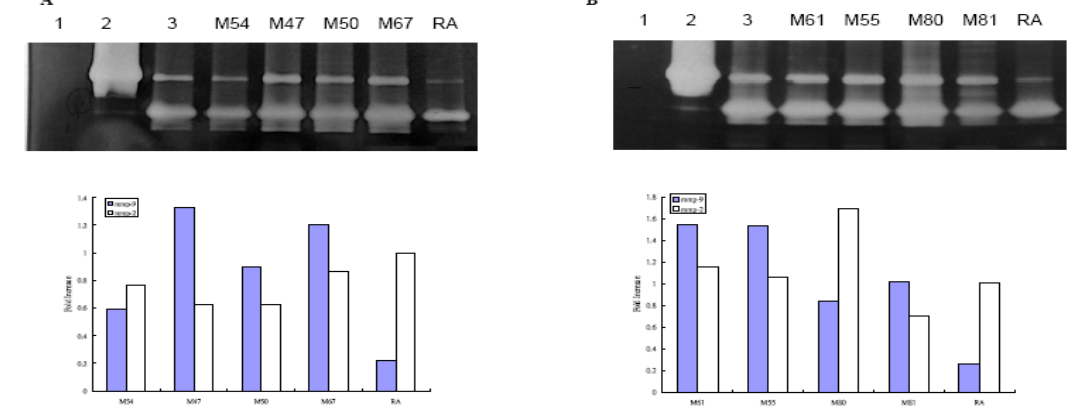
A and B represent MMP-2 and -9 activities of indicated Taiwanese native plants. Lanes 1-3 are negative controls, rMMP-9, medium alone without treatment, respectively. The lower panel represents the semiquantitation the MMP-2 and –9 activities by densitometer (gray and white bars represent MMP-9 and MMP-2 activities, respectively). Figure 2. Effect of Taiwan native plants on MMP-2 and –9 activities by zymography gel after UVB